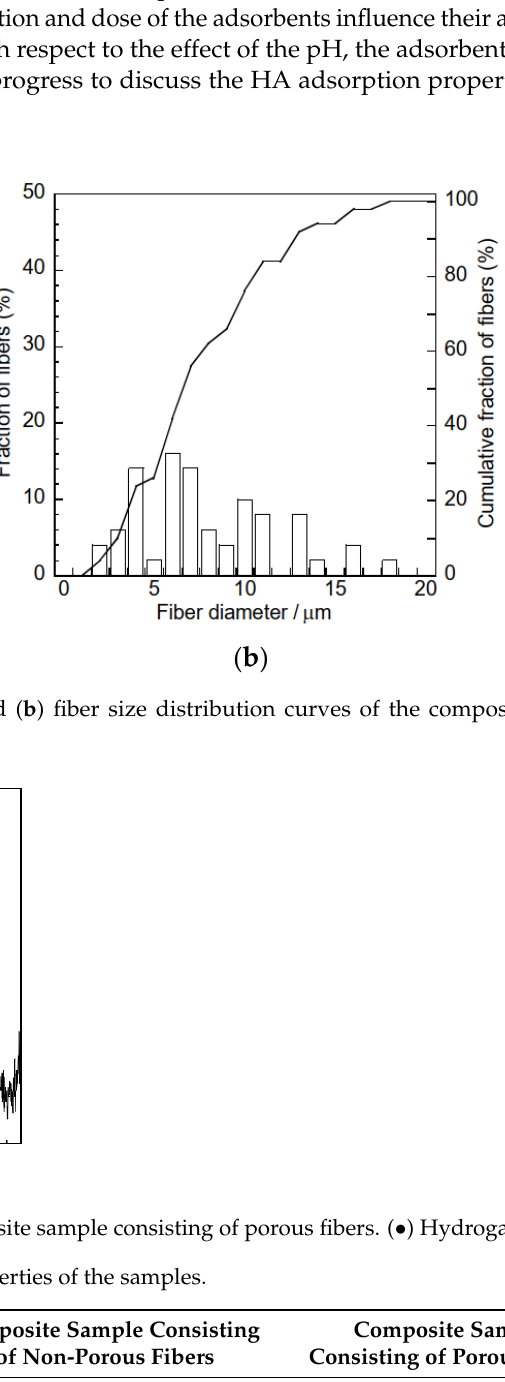
Table 1. Humic acid adsorption properties of the samples.